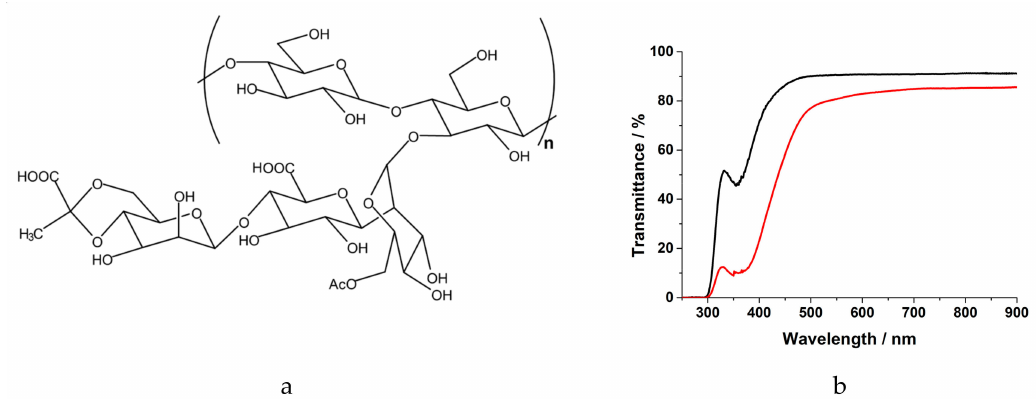
Figure 1. ( a ) General molecular structure of XG, with “n” ranging between 2000 and 20,000. ( b ) UV − Vis transmittance spectra of aqueous liquid (black) and xanthan-based hydrogel (red)